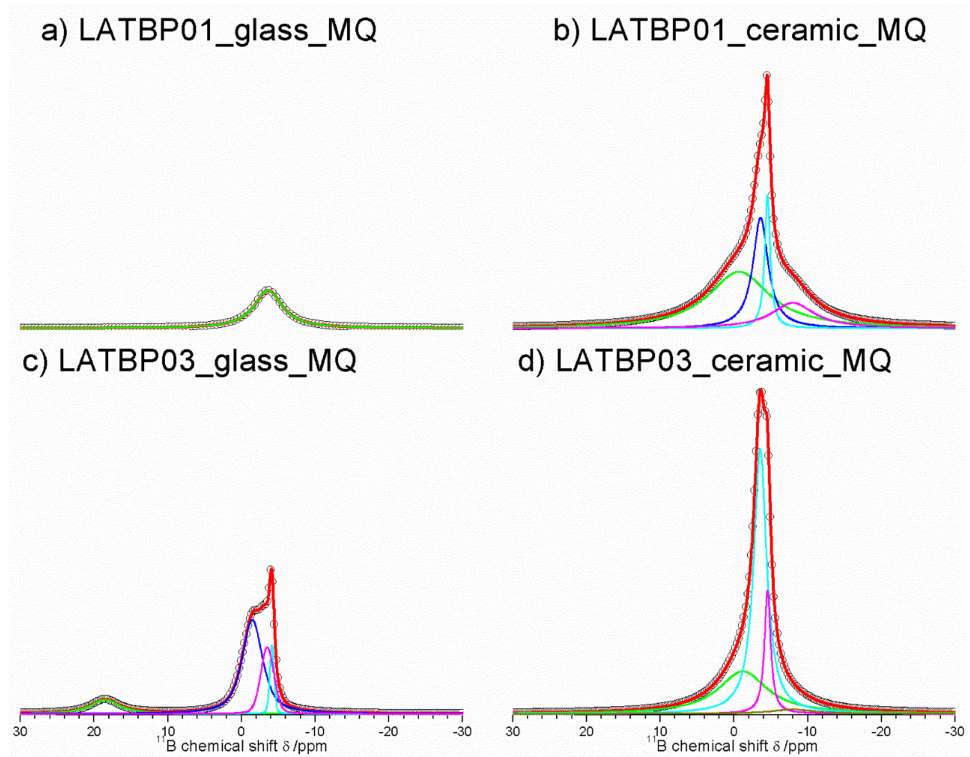
Figure 13. 1 D 11 B MAS NMR spectra of the LAT(B)P_BM series. ( a ) LATBP01_glass_BM ( b ) LATBP01_ceramic_BM ( c ) LATBP03_glass_BM ( d )